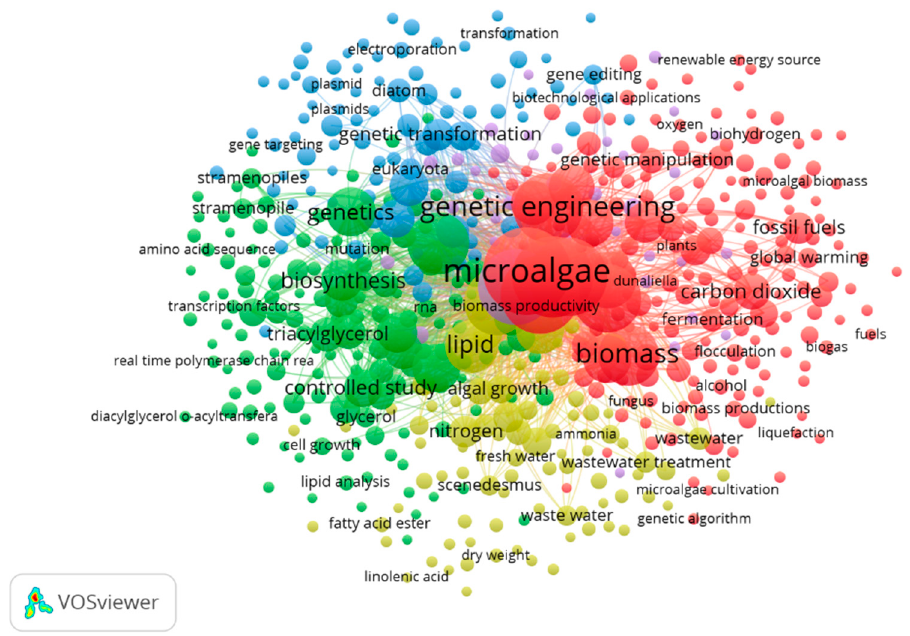
Figure 4. The type of published paper.